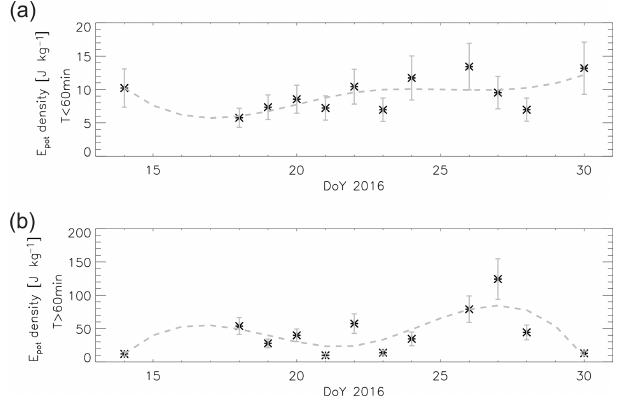
Figure 6. Panel (a) shows the nightly mean wave potential energy density (based on GRIPS 9 measurements at Kiruna) for periods shorter than 60min, while panel (b) refers to periods longer than 60min. The nightly mean OH*-equivalent (angular) BV frequency was taken from SABER. For the night from 27 to 28 January, co- incident SABER profiles were not available; therefore, the mean based on the values of the night before and after was calculated. A cubic spline approximation is superimposed (dashed